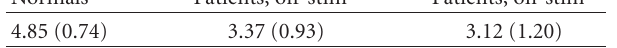
Table 2: Within-utterance relative syllable length variability by group. The average relative deviation is shown for each group